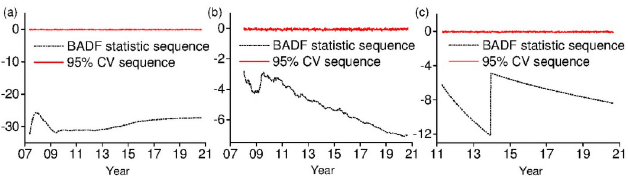
Fig 5. PWY time-stamping results. This figure plots the BADF statistic series and their simulated 95% critical value series for three sectors: (a) CSI 300, (b) SMEs, and (c) GEM.